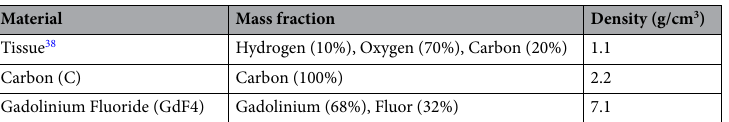
Table 1. The cell tissue used in present calculations consists of H, O and C with the mass fraction presented in this table according to Ref. 38 . The target materials with fractional mass also have been presented.